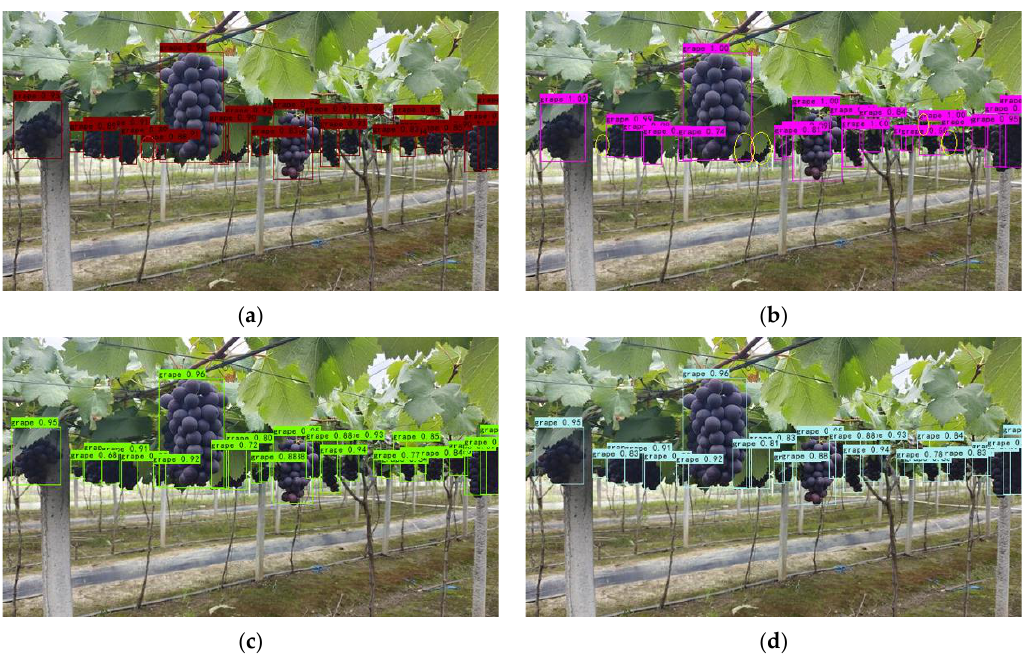
Figure 16. Actual grape detection results of the large network models: ( a ) Faster RCNN ( b ) SSD ( c ) YOLOv5l ( d ) YOLOv5x. The yellow circle represents the missed detection of grapes. The yellow circle represents the missed detection of grapes.